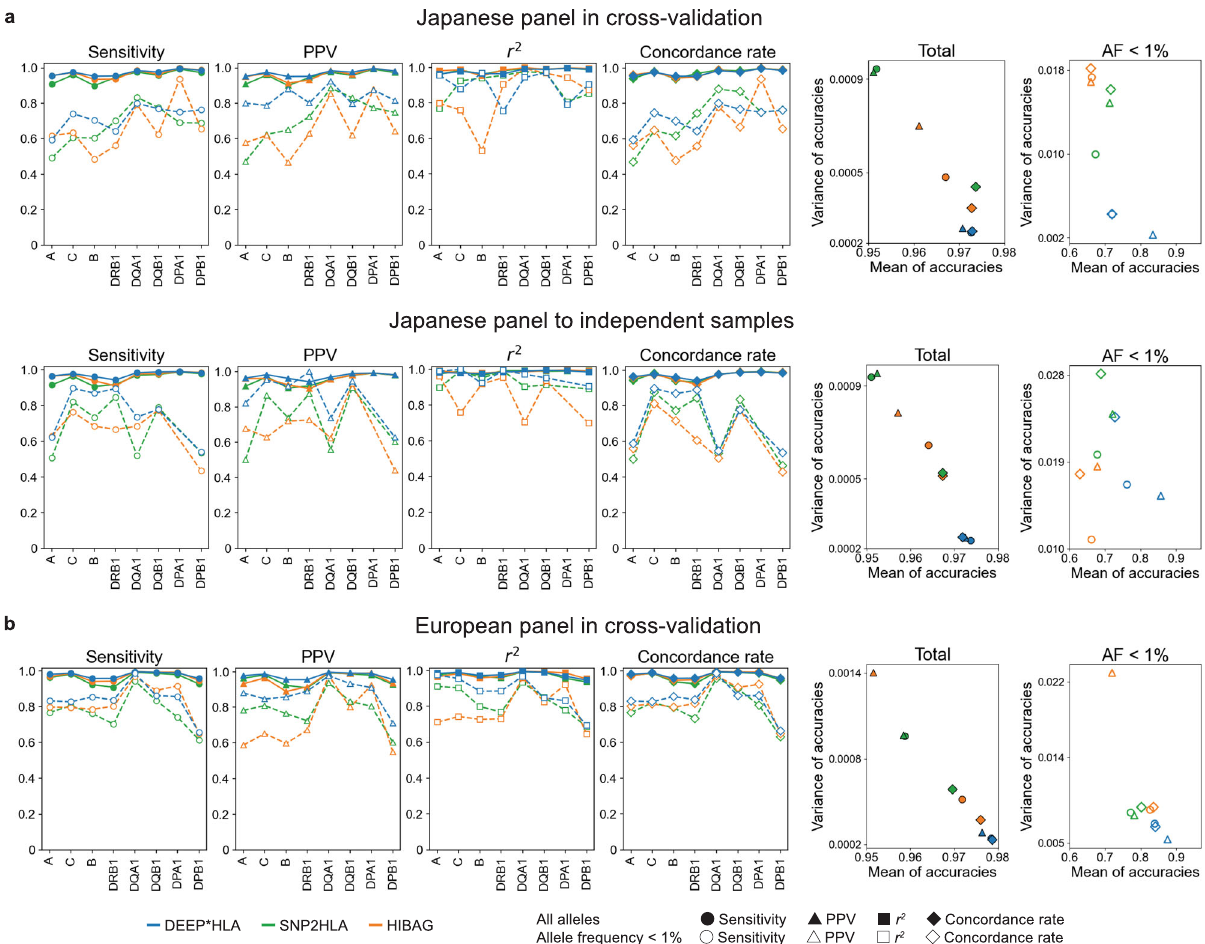
Fig. 3 Comparison of imputation accuracy between different HLA genes. Each panel represents accuracy in eight classical HLA genes evaluated in the Japanese panel in cross-validation ( a , upper), the Japanese panel to the independent data ( a , lower), and the European panel in cross-validation ( b ). Solid and dashed lines correspond to the accuracy of all allele and allele with frequency <1%, respectively. The right two scatter plots represent the relation between the mean and variance of each metric among different HLA genes for individual methods. R 2 metric is not shown because it is not an additive statistic. Source data are provided as a Source Data fi le. PPV positive predictive value, AF allele